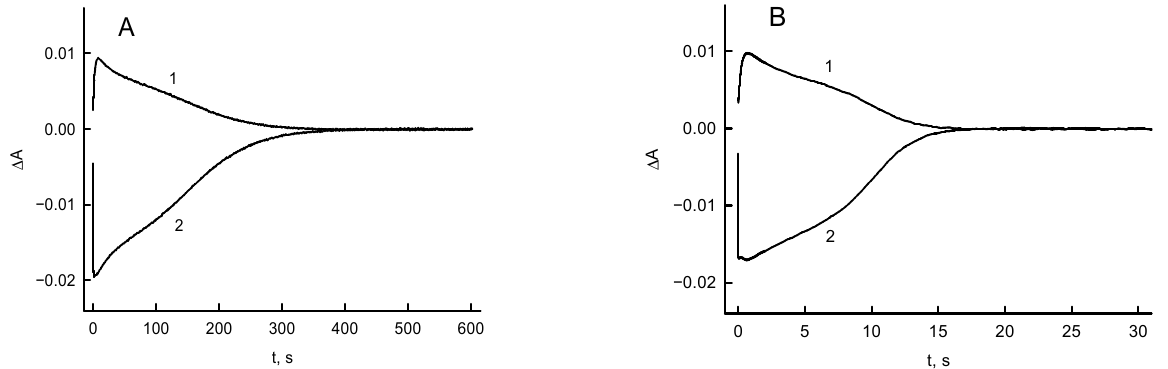
Figure 6. The absorbance changes at 600 nm (1) and 460 nm (2) during the reduction of Rp FNR (4.0 µM) by 50 µM NADPH and its subsequent reoxidation by oxygen ( A ) or 250 µM duroquinone ( B ). Concentrations are reported after mixing.